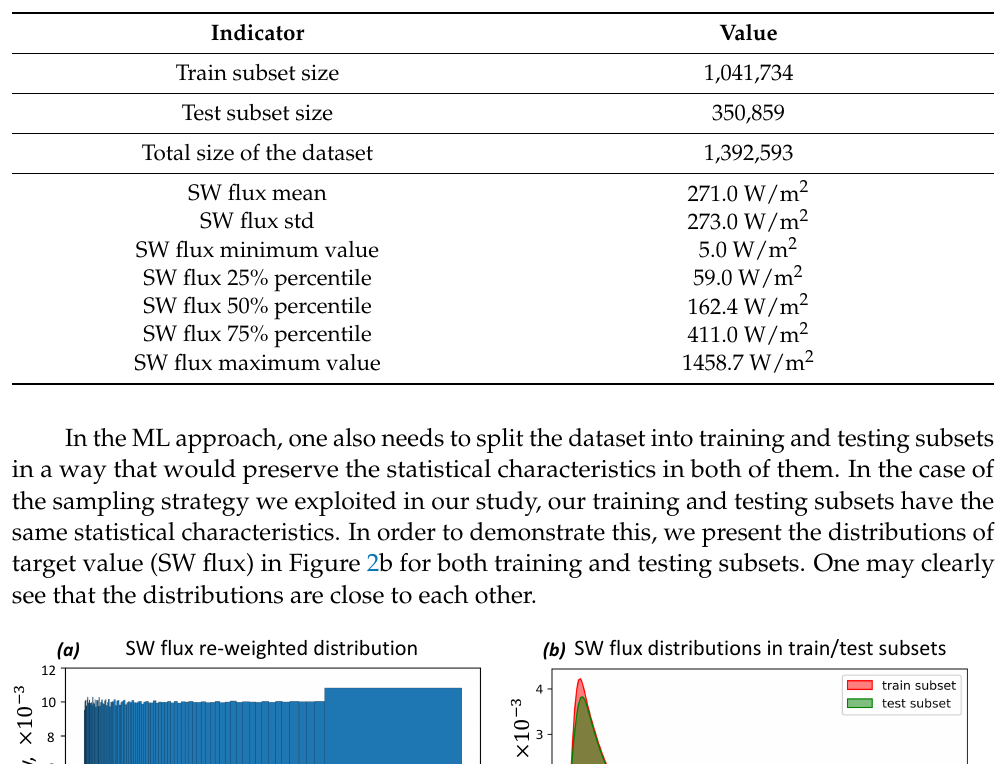
Table 2. Quantitative summary of the dataset in our study.